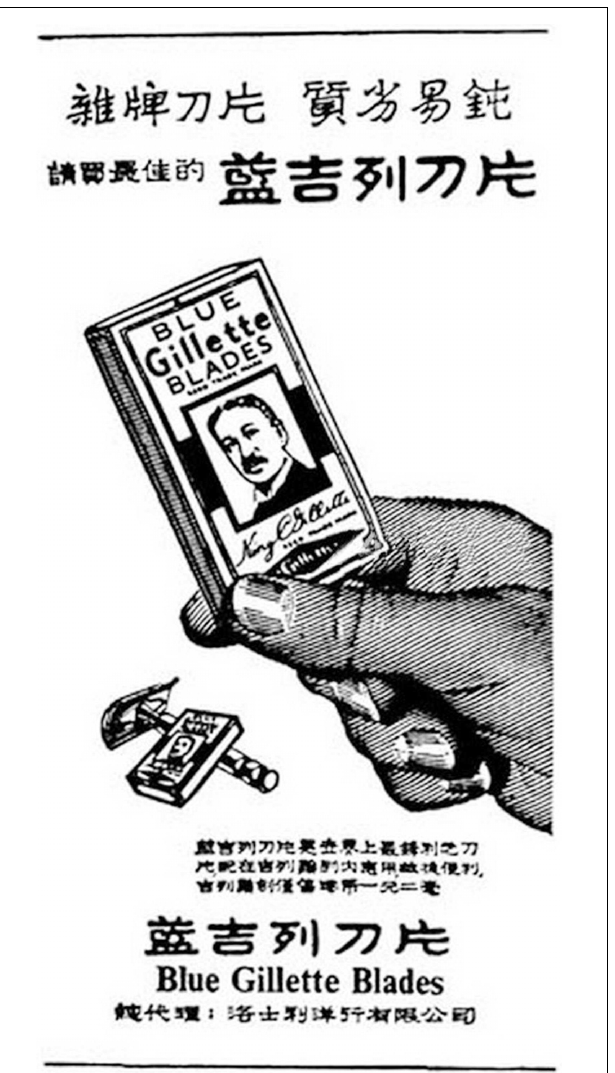
FIGURE 1 | Hong Kong newspaper advertisement from the 1950s for World Filter Cigarettes. The Chinese script (written Cantonese) at the bottom of this advertisement for ( lit. America Gold Brand filter cigarettes) is in the older RL direction. (Source: i.uwants.com/u/attachments/day_101118/20101118_ad66e669de9c3f1e16d 90gyl0bEOwmZY.jpg; accessed 6th July 2012.)